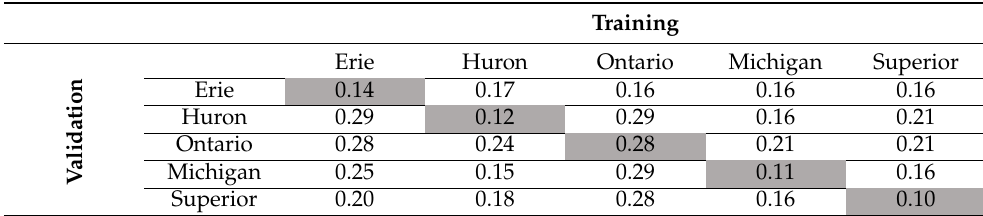
Table 8. Summary statistics of the coefficient of determination (R 2 ) on the estimation of the difference between GEDI and in situ water levels using a random forest model trained using I , C , and W variables over a lake and applied to the remaining four. The diagonal line represents the results of the 5-fold cross-validation. Training Erie Huron